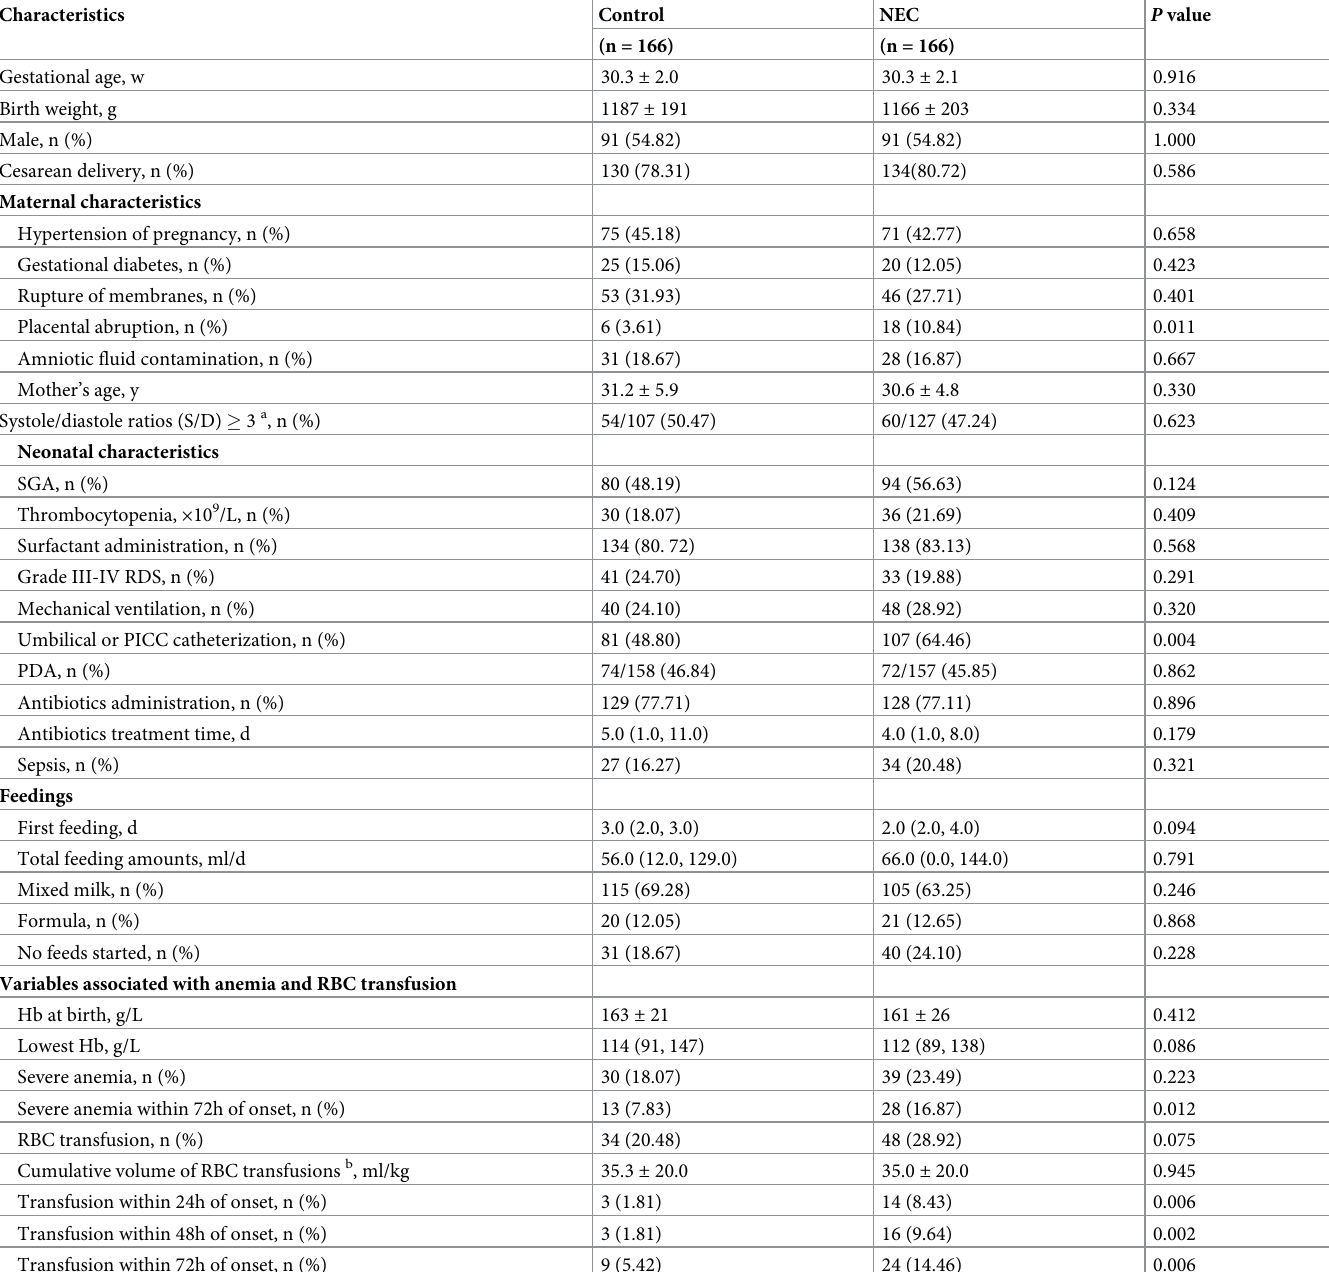
Table 2. Maternal and neonatal clinical characteristics of the cases and controls in very low birth weight infants. Characteristics